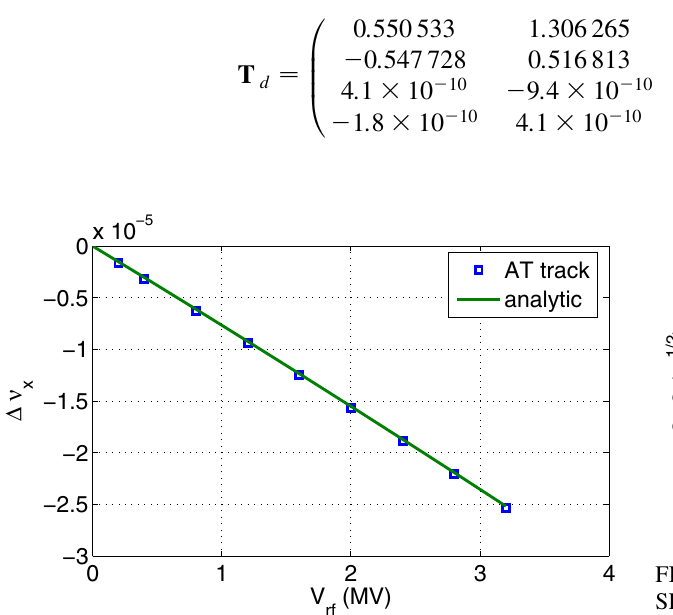
FIG. 1. (Color) The synchrobetatron coupling induced betatron obtained by AT tracking is compared to analytic detuning (cid:2) (cid:9) x calculation with Eq. (42). The rf gap voltage is varied from 0.2 to 3.2 MV.